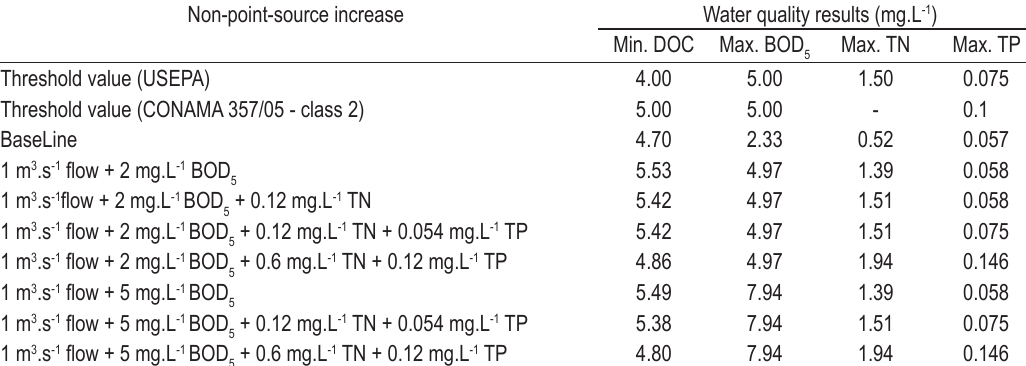
Table 7. Water quality after accounting for increased non-point-source contributions in several